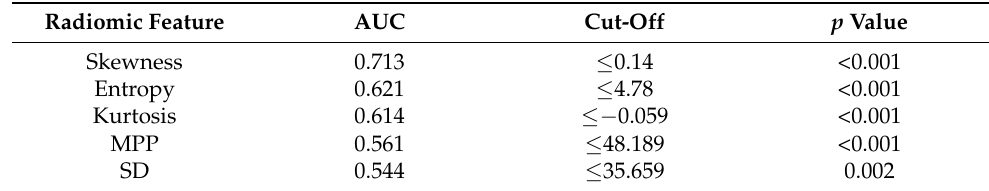
Table 3. ROC Curves for Radiomics Features. Association with